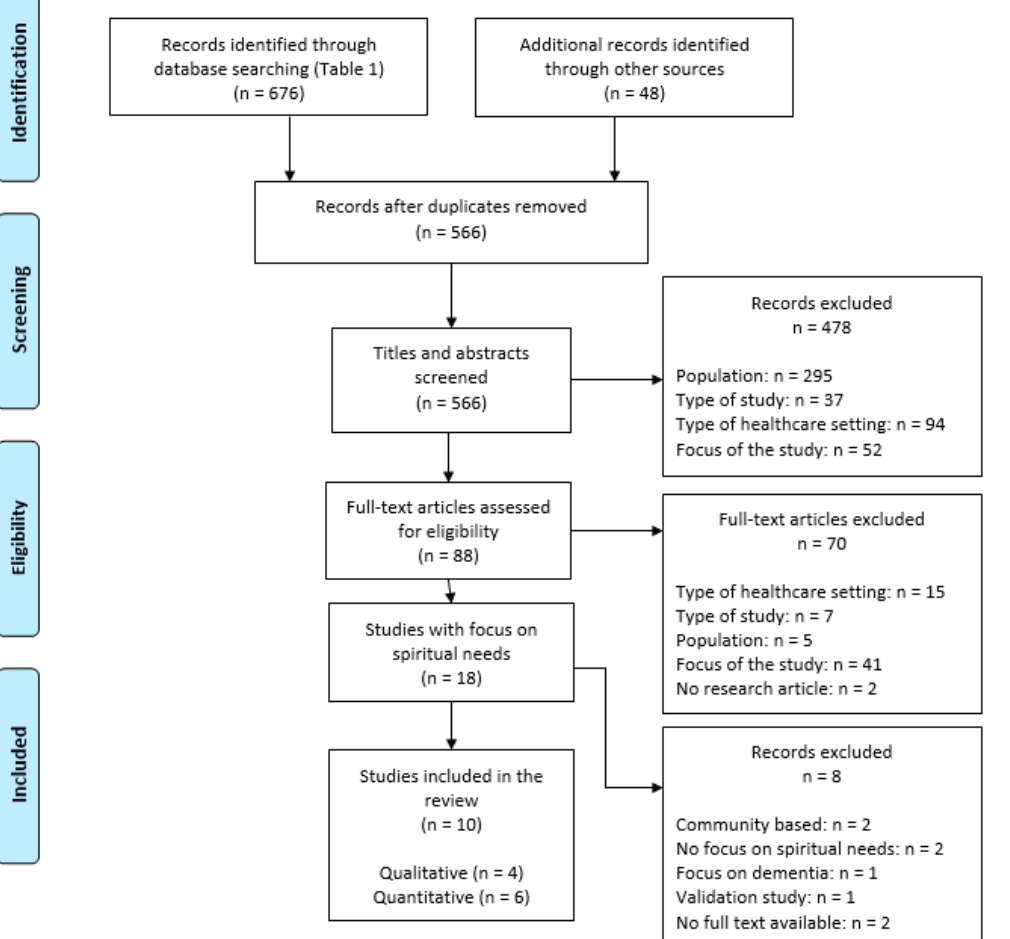
Figure 1. Overview of the study selection process, PRISMA Flow Diagram (Moher et al. 2009).